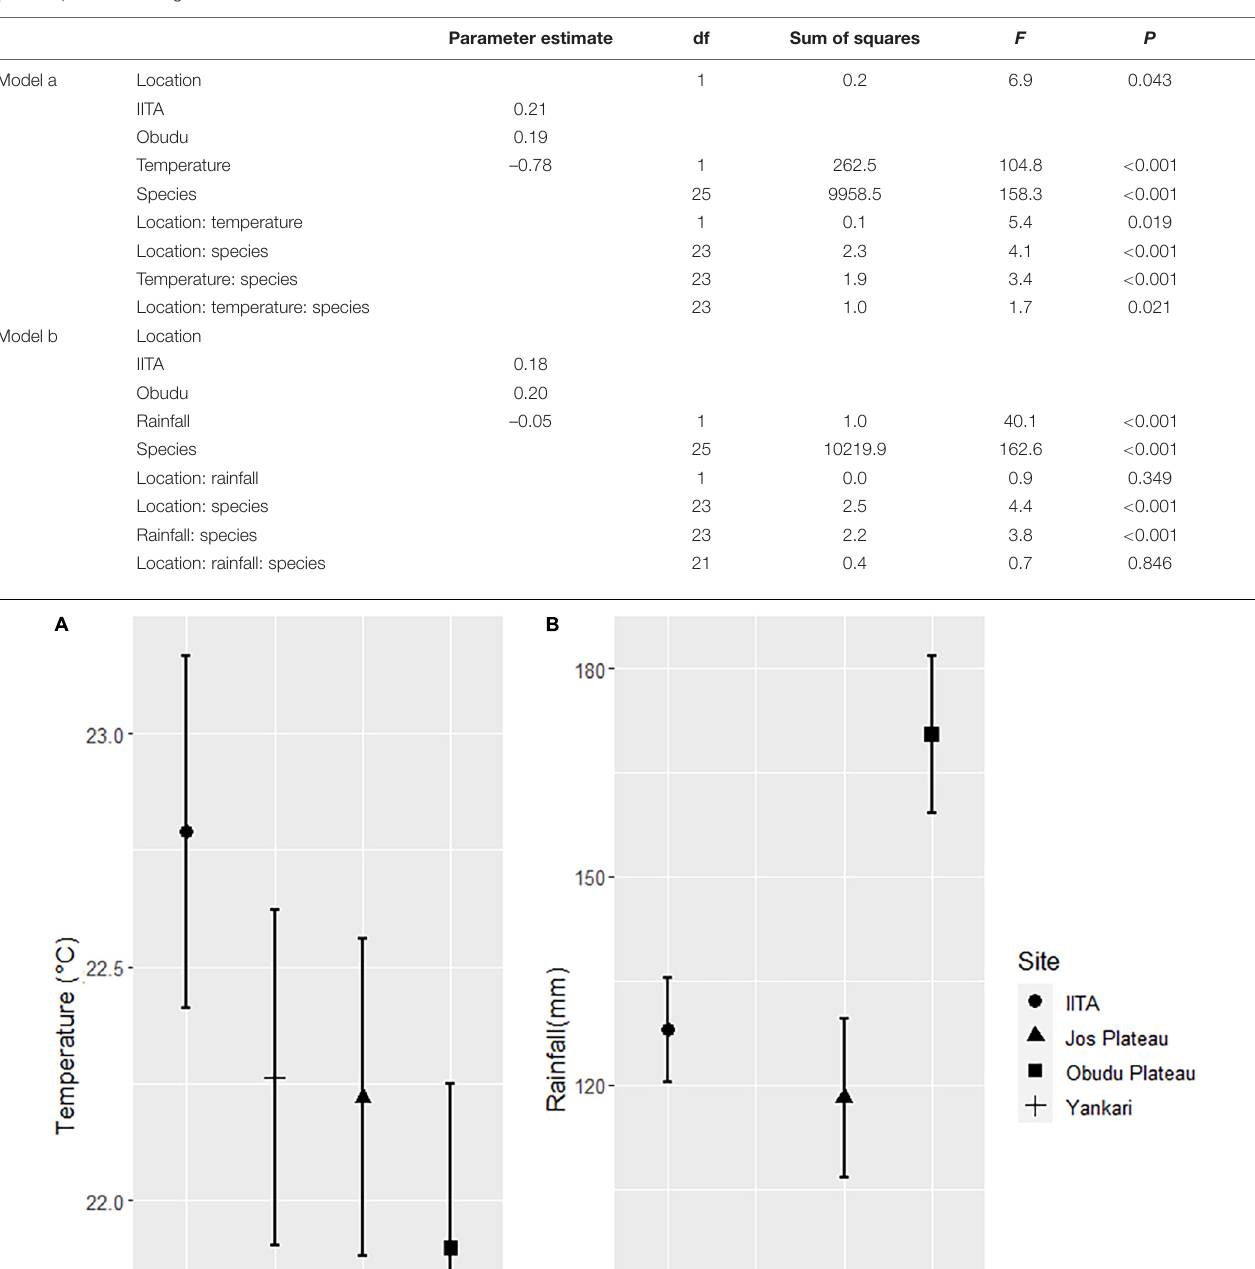
TABLE 2 | General Linear Model investigating the relationship between body size (PC1) with sites (lowland vs. montane), species, temperature (model a), and rainfall (model b) in northern Nigeria. Parameter estimate df Sum of squares F P